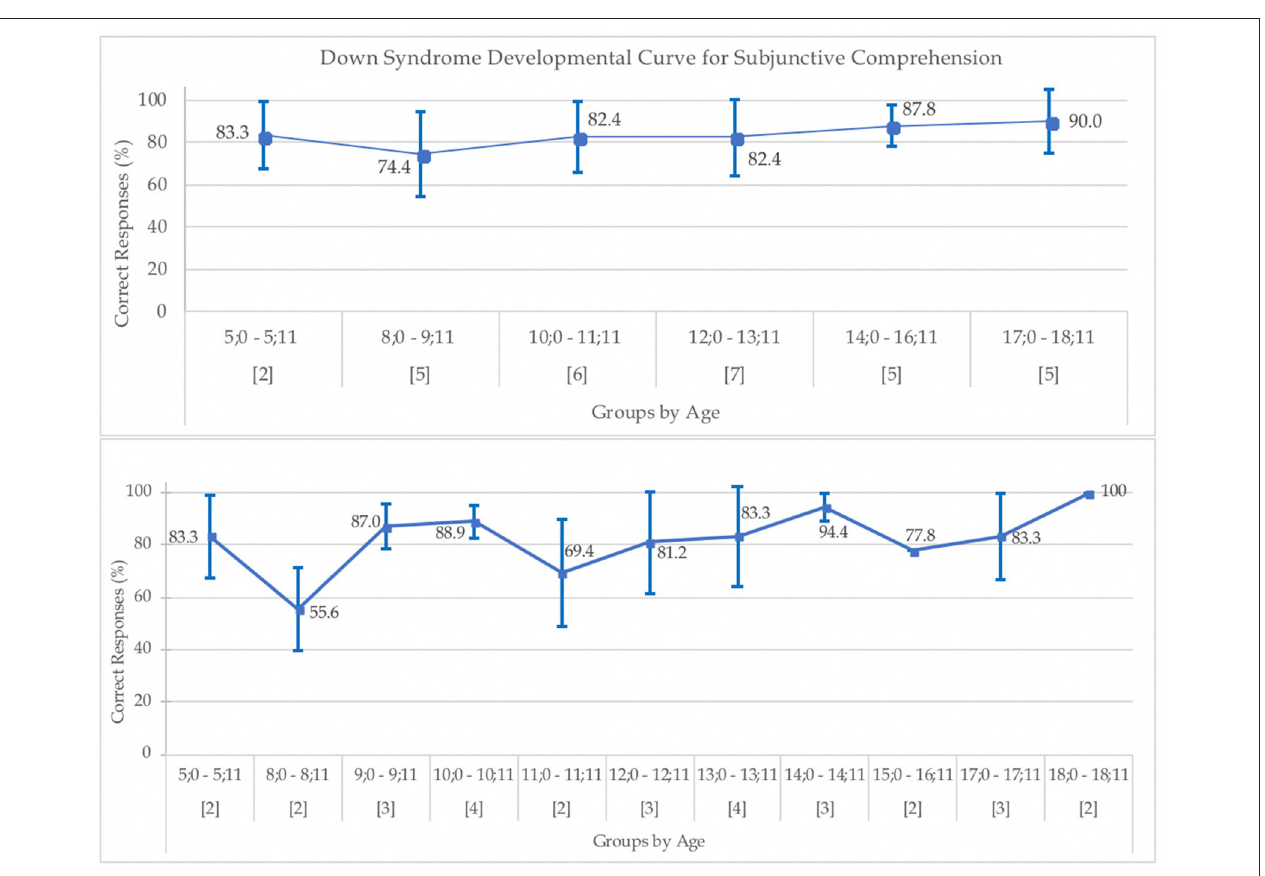
verb’s inflectional marking depends on the matrix verb— with the same subject–verb agreement marking, but different tense marking—participants with DS presented highly accurate